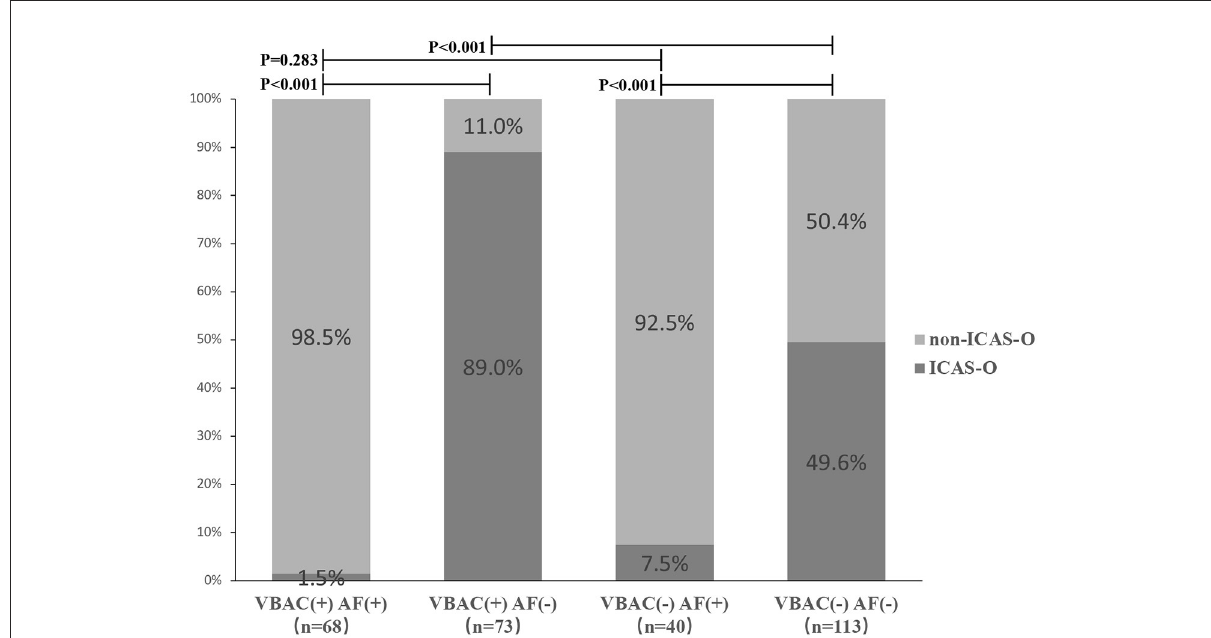
FIGURE3 Proportions of ICAS-O classified according to with and without vertebrobasilar calcification (VBAC) and atrial fibrillation (AF). Non-ICAS-O more frequently occurred in VBAC( + ) AF( + ) group and VBAC(-) AF( + ) group compared to the VBAC( + ) AF(-) group ( P < 0.001) and VBAC(-) AF(-) group ( P < 0.001). The difference between the VBAC( + ) AF( + ) group and the VBAC(-) AF( + ) group was not statistically significant ( P = 0.283). However, the VBAC( + ) AF(-) group shows ICAS-O more frequently than the VBAC(-) AF(-) group ( P < 0.001).